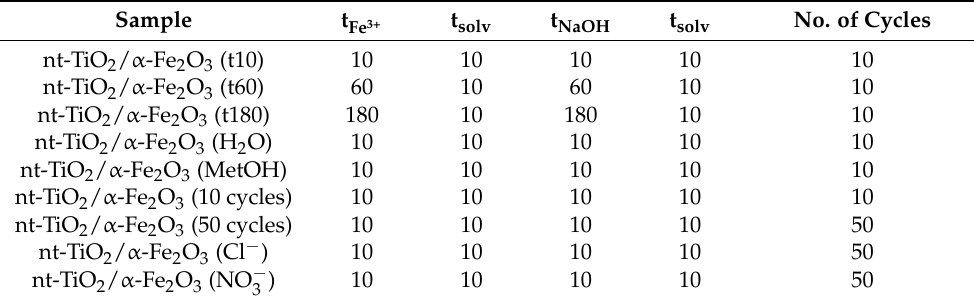
Table 1. SILAR conditions assayed in the synthesis of α -Fe 2 O 3 onto nt-TiO 2 . The parameters are as follows: t ( s ) corresponds to the time immersed in the corresponding solution (Fe 3+ , solvent used, and